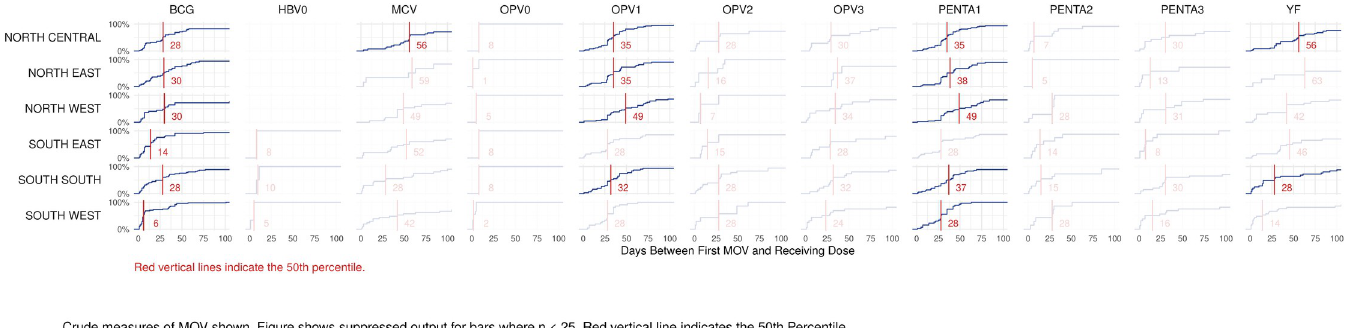
Fig 9. Cumulative distributions of time to correction, in days, for missed opportunities for vaccination, by dose and zone, Nigeria MICS/NICS 2016–17.